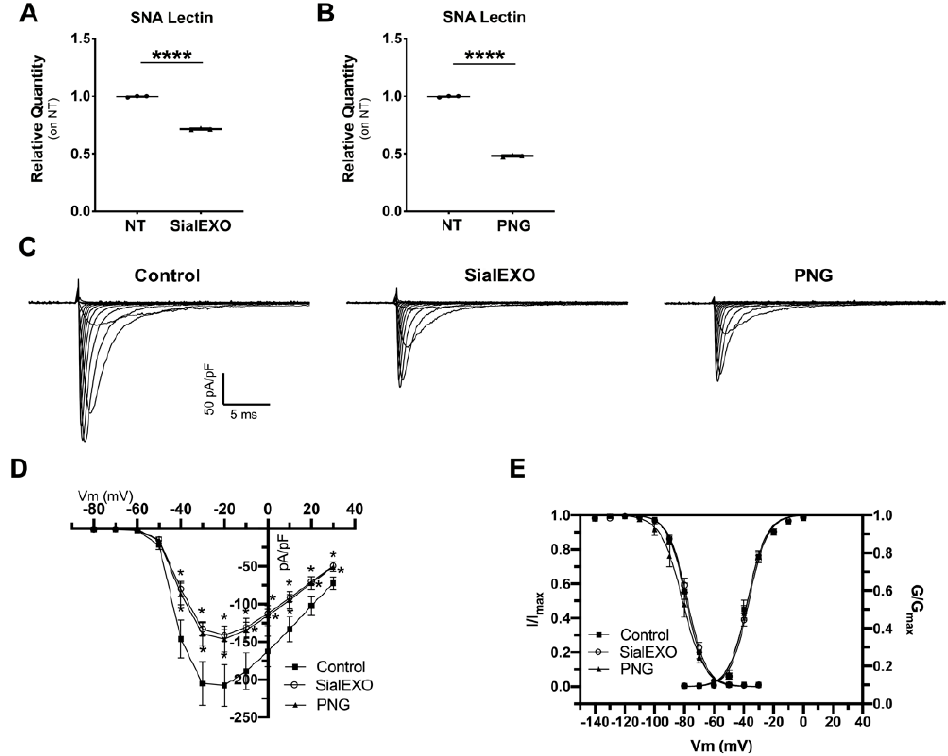
Figure 7. Reduced sialylation in HEK293A cell overexpressing NaV1.5 caused a decrease in inward sodium currents. ( A ) Flow cytometry analysis of membrane sialylated protein levels in HEK293A cells overexpressing NaV1.5 after SIA treatment. ( B ) Flow cytometry analysis of membrane sialylated protein levels in HEK293A cells overexpressing NaV1.5 after PNG treatment. ( C ) Representative families of current traces evoked by the protocol described in the Methods section. ( D ) Current- voltage relationship obtained for the control condition (filled square, n = 15), SIA and PNG incubation (empty circles, n = 24 and filled triangles, n = 14, respectively). ( E ) Voltage dependence of activation and inactivation in the three conditions tested. **** p < 0.0001, * p < 0.05 (One-way